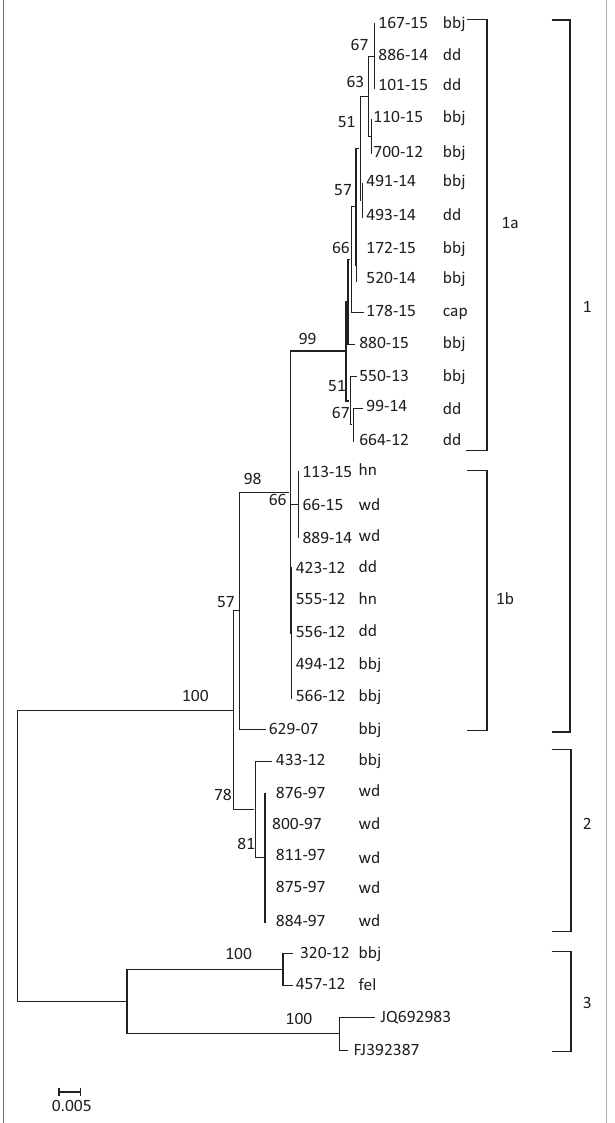
Horizontal lines indicate the degree of nucleotide sequence divergence according to the scale bar at the bottom. The main clades (1 and 2) of the viruses involved in the most recent (2014–2015) and previous rabies outbreaks and the mongoose variant (clade 3) used as an out-group in this analysis, are indicated on the right-hand side of the figure. Clades 1a and 1b. FIGURE 4: A phylogenetic tree showing the genetic placement and relationships of the recent wild dog rabies virus (clade 1) with rabies virus from other wild carnivores and domestic dogs associated with rabies outbreaks in the North West province.